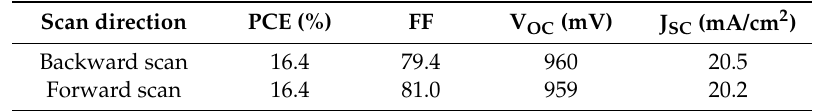
PCE: power conversion efficiency, FF: fill factor, V OC : open circuit voltage, J SC : short circuit current density.